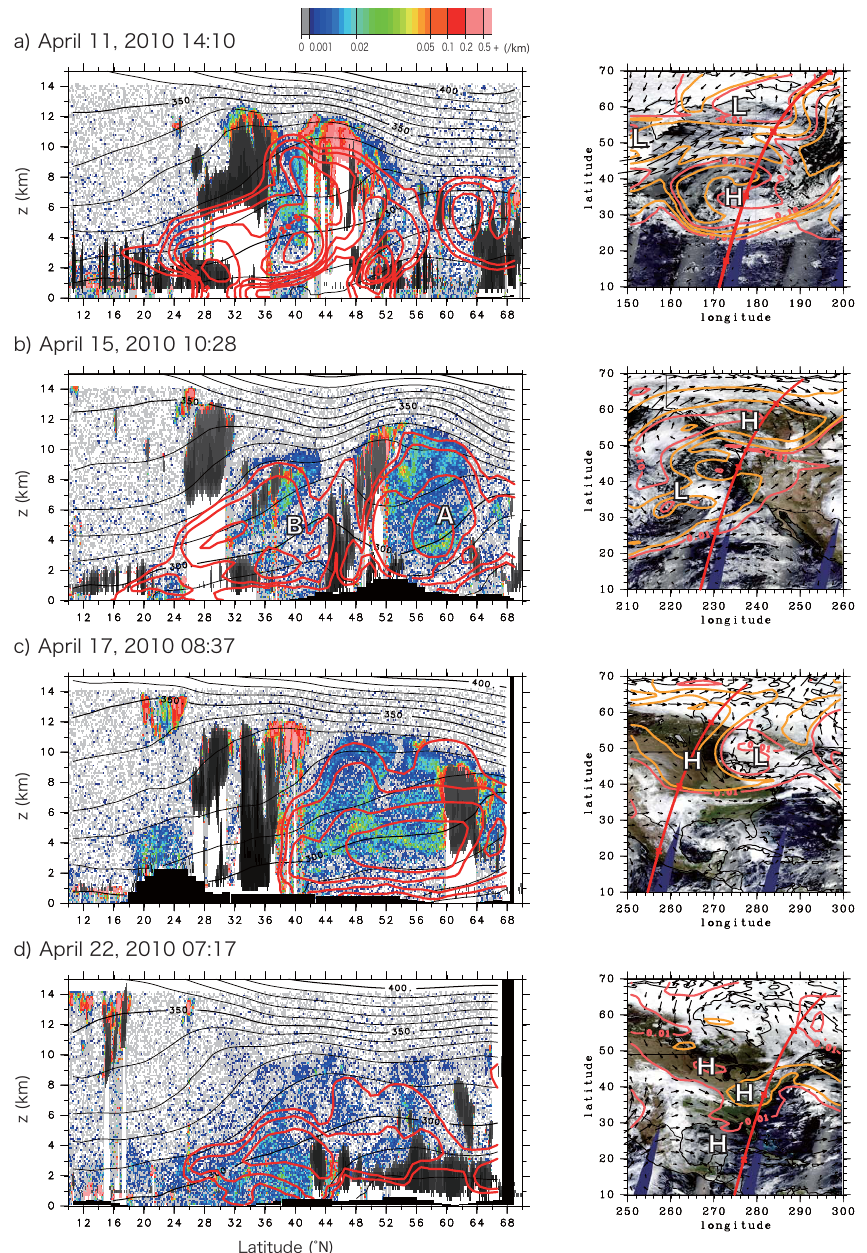
Fig. 2. (Left column) Snapshot of dust extinction coefficient cross-section observed by CALIOP (color), CloudSat CPR echo intensity (black/white), and simulated by SPRINTARS (red). The black line indicates potential temperatures. (Right column) CALIPSO path, SPRINTARS dust AOT distribution, and MODIS cloud image. (a) 11 April, (b) 15 April, (c) 17 April, and (d) 22